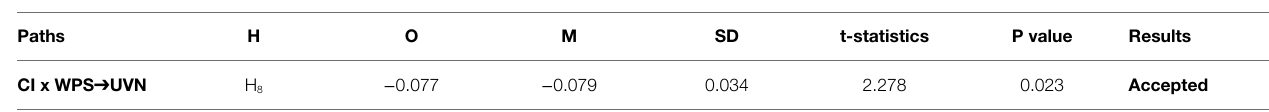
TABLE 7 | Moderating effects of the